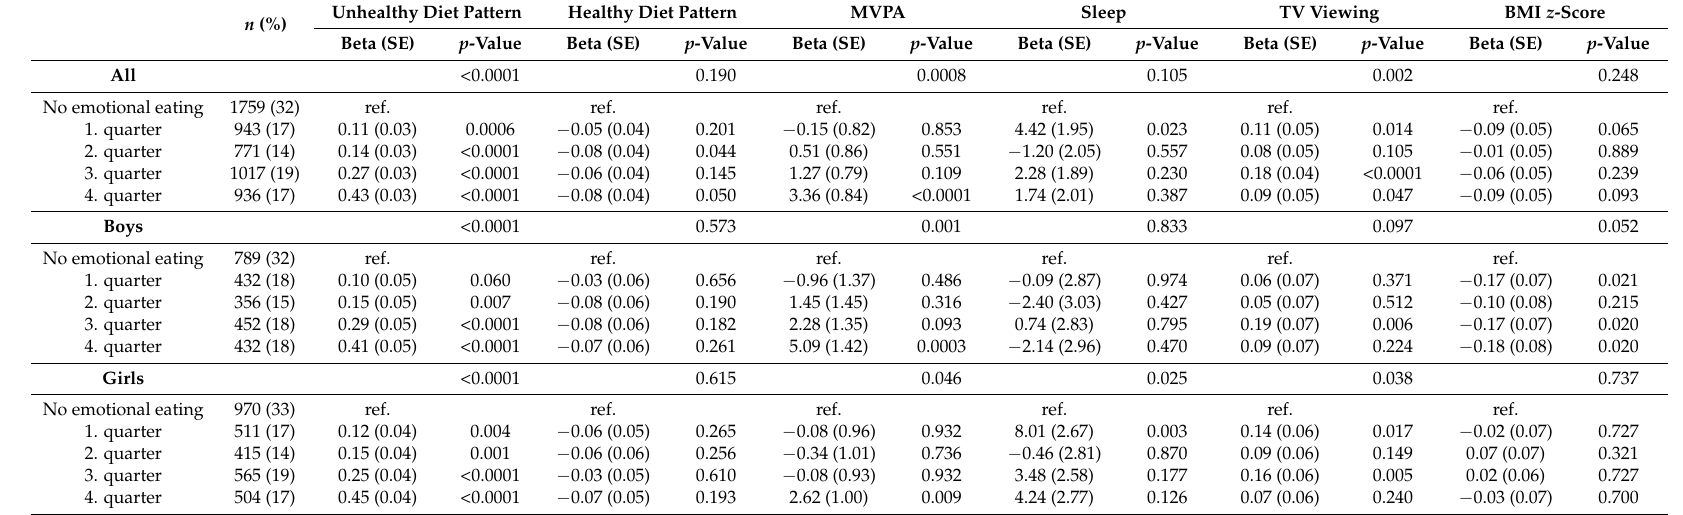
Table 5. The associations a between categorized emotional eating factor scores b and outcome variables c